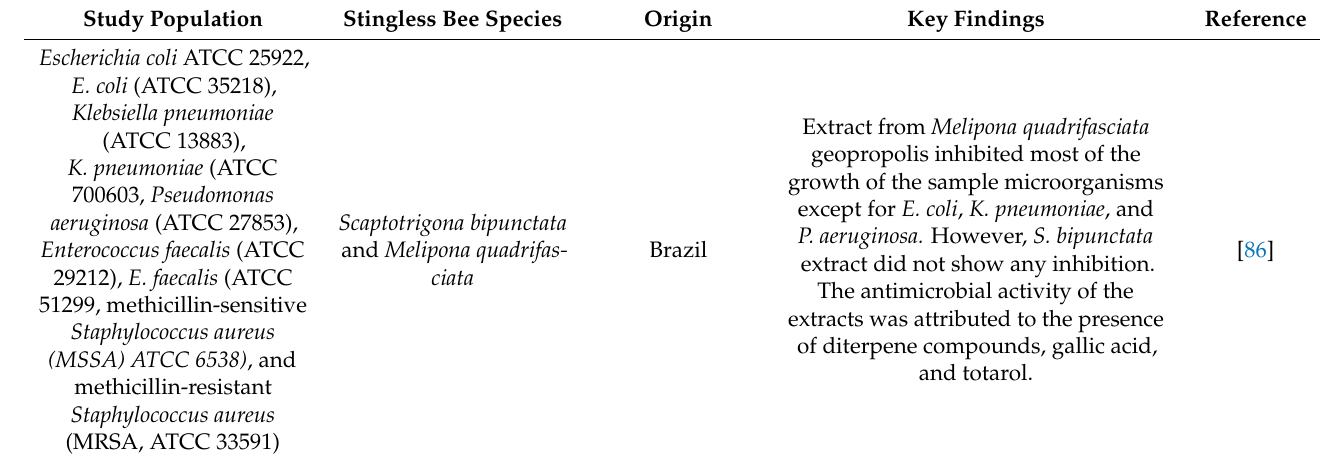
Table 6. Stingless bee propolis antimicrobial